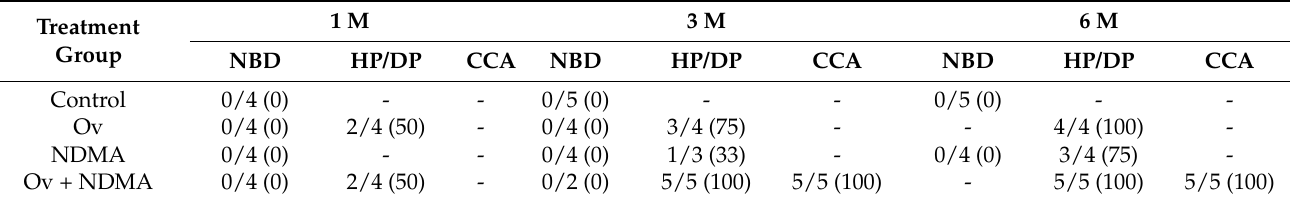
Figure 1. MPS1 is associated with cholangiocarcinogenesis in a hamster model. ( A ) Immunohistochemistry (IHC) staining of MPS1 in liver tissues from four groups of hamsters including control, carcinogen N-nitrosodimethylamine (NDMA)-treated, Ov-infected, and combination of NDMA + Ov at one, three, and six months after treatment. ( B ) Comparison of the percent of MPS1 positive cases between NBD, hyperplasia/dysplasia (HP/DP), and Cholangiocarcinoma (CCA). Median H-score of MPS1 in hamster CCA tissues was 70, which was used as a cut off value to categorize the samples into two groups; MPS1 negative and MPS1 positive. Table 1. MPS1 expression in Ov-associated CCA in hamster model.